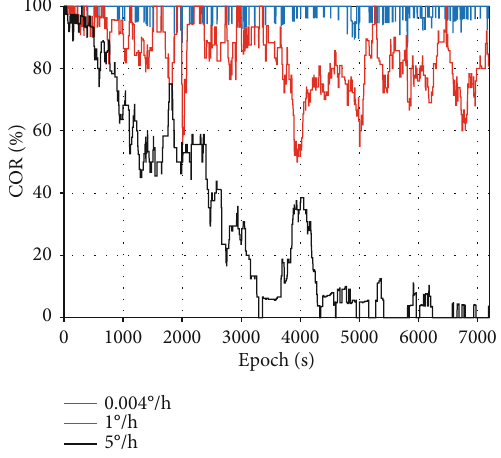
Figure 11: COR for di ff erent gyroscope biases.